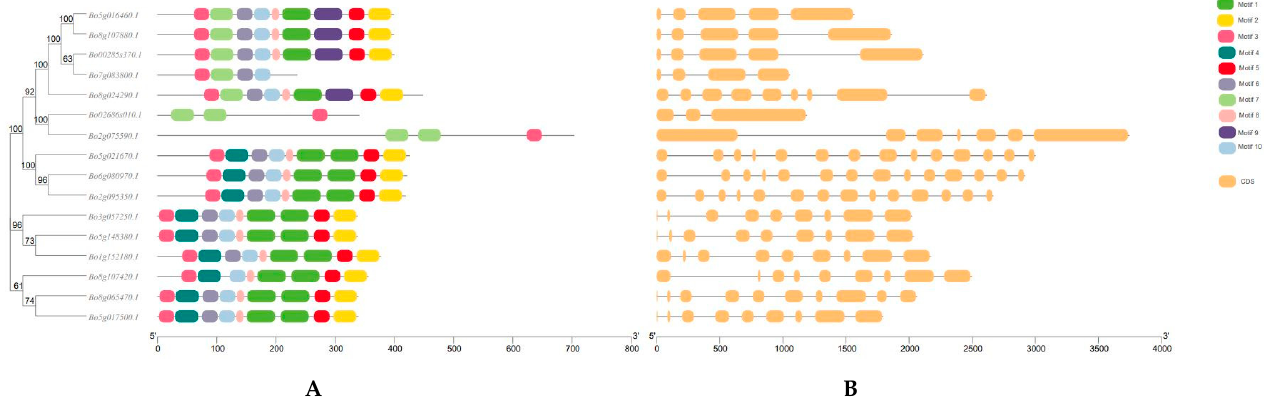
Figure 2. ( A ) Conserved motif distribution of BoGAPDH gene; the 10 conservative motifs are represented by different colors. ( B ) The structural distribution of the BoGAPDH gene; yellow represents exons, lines represent introns.